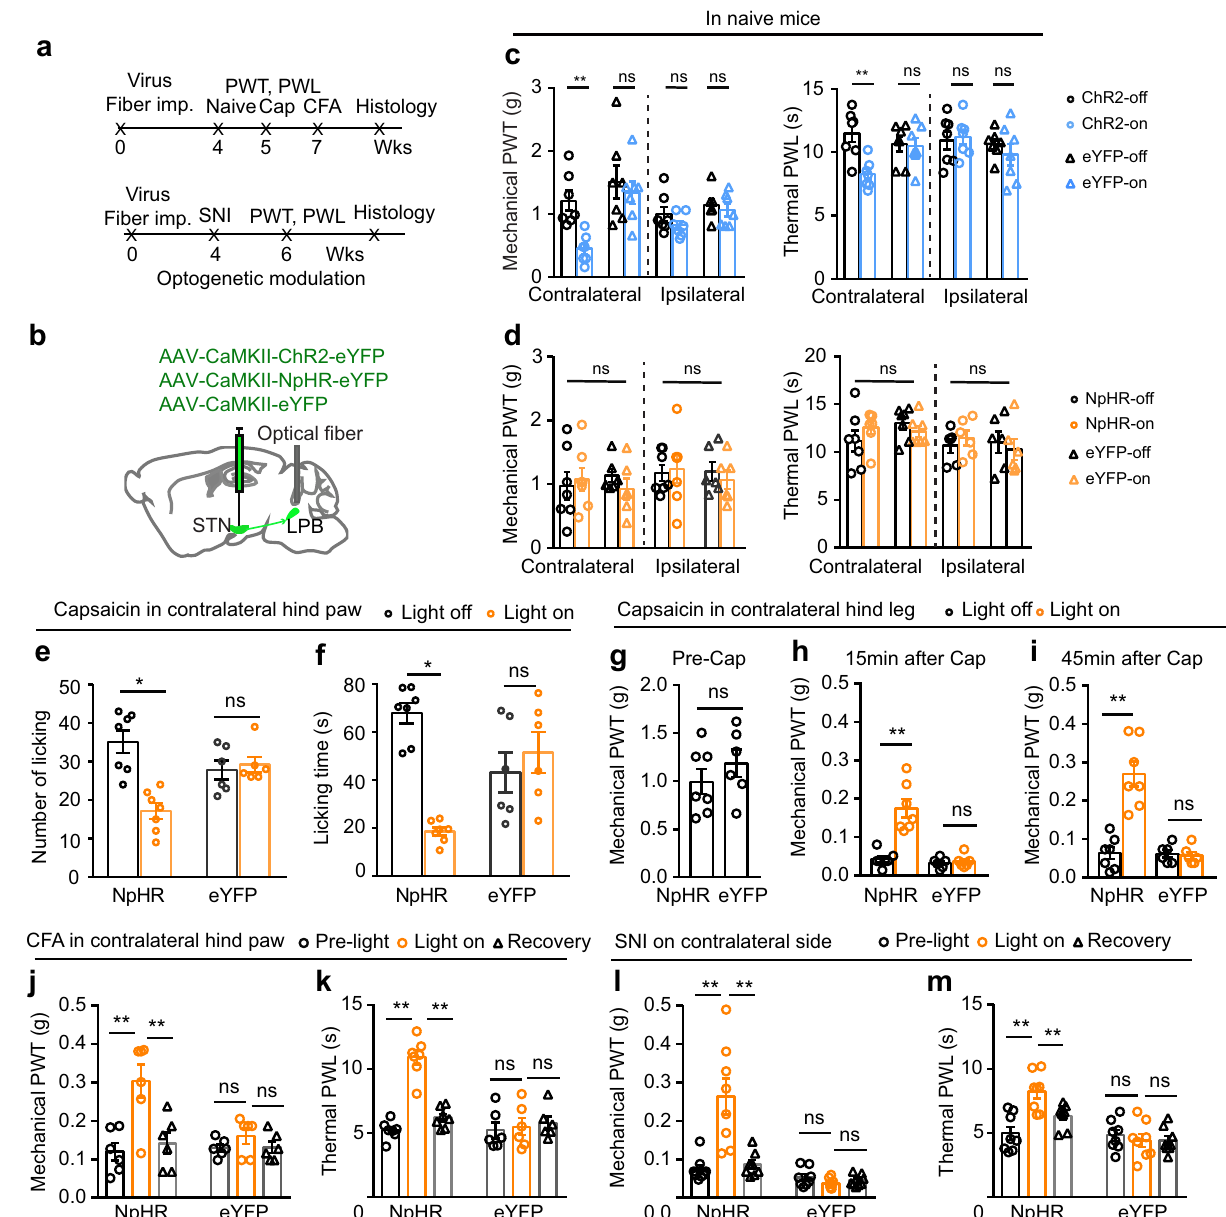
Fig. 6 | The STN – LPB projection modulates pain-like behaviors. a , b Timeline and diagram for optogenetic manipulation of the STN – LPB projection. c Effect of activation of the STN – LPB projection on pain thresholds in ChR2-expressing mice. PWT: F (1, 24) = 12.02, P =0.002; PWL: F (1, 12) = 10.46, P =0.0035; n =7 per group. d Effect of silencing of the STN – LPB projection on pain thresholds in NpHR- expressing mice. PWT: F (1, 22) = 0.4, P =0.53; PWL: F (1, 22) = 0.14, P =0.71; n ≥ 6 per group. e , f Effect of silencing of the STN – LPB projection on the frequency ( F (1, 11) = 19.16, P =0.0011) and duration ( F (1, 11) = 44.53, P <0.0001) of licking/ fl inching behavior induced by capsaicin hind paw injection. n =7 in NpHR, n =6 in eYFP.